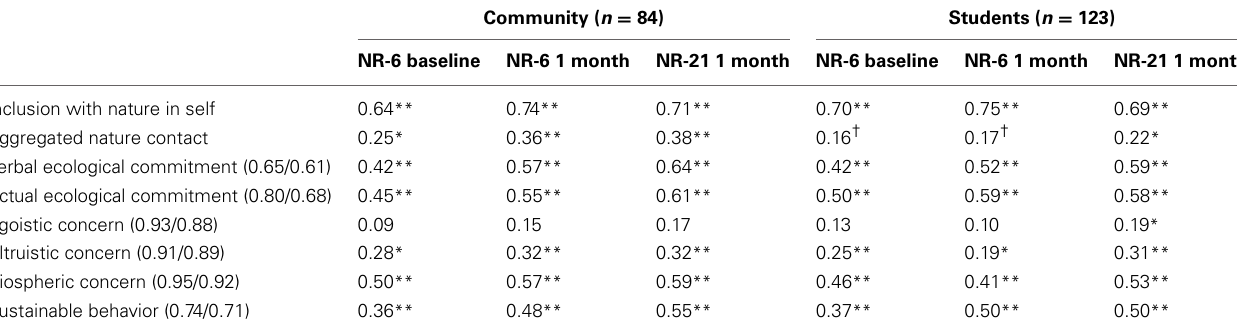
Table 7 | Study 4—nature relatedness correlations at baseline and one month with environmental measures at one